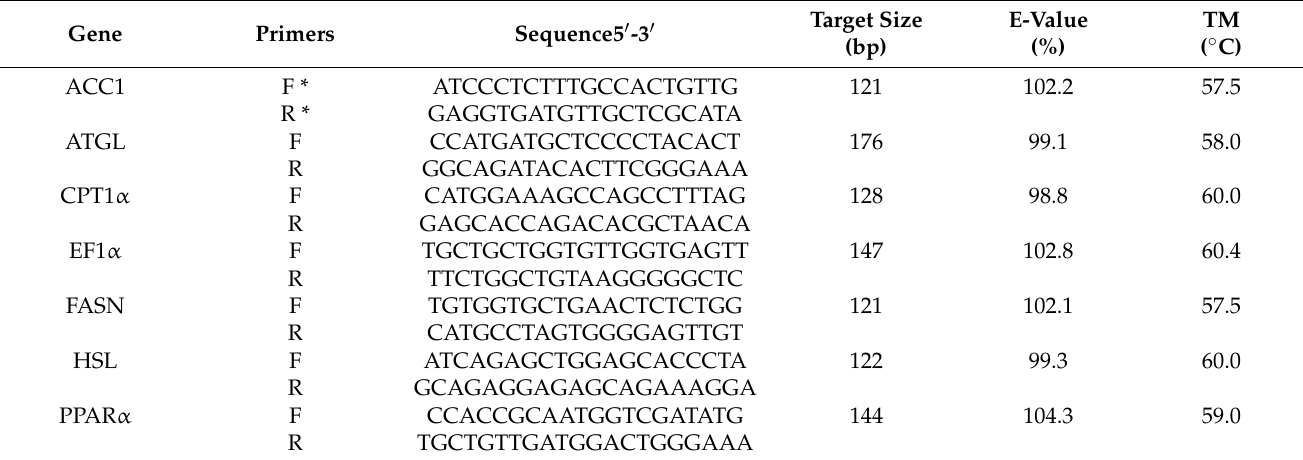
Table 2. Primer sequences used for real-time quantitative